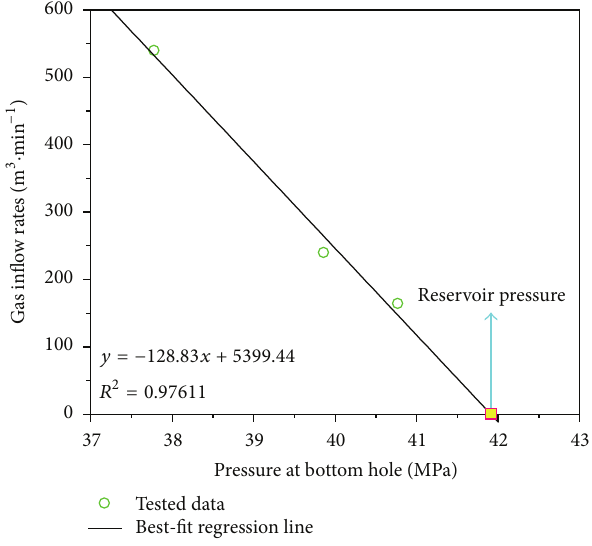
Figure 14: A comparison between estimated and actual permeabil- ity